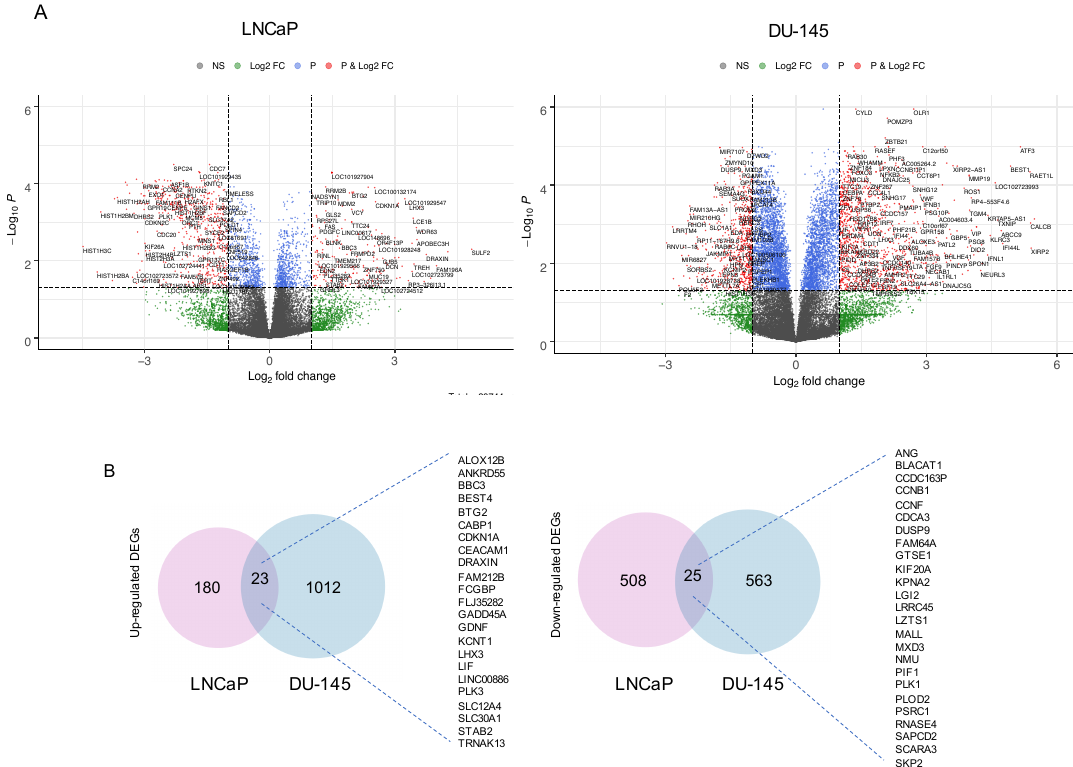
Figure 2. Global changes in the C-1311-regulated transcriptional profile in PCa cells. LNCaP and DU-145 cells were treated with 1 µ M C-1311 for 24 h and subjected to RNA-seq analysis ( n = 3). ( A ) Volcano plot of the di ff erently expressed genes in PCa cells exposed to C-1311. The horizontal line at a false discovery rate (FDR) = 0.05; vertical line at | log2FC | = 1. ( B ) Venn diagram of di ff erentially expressed genes (DEGs) in PCa cells exposed to